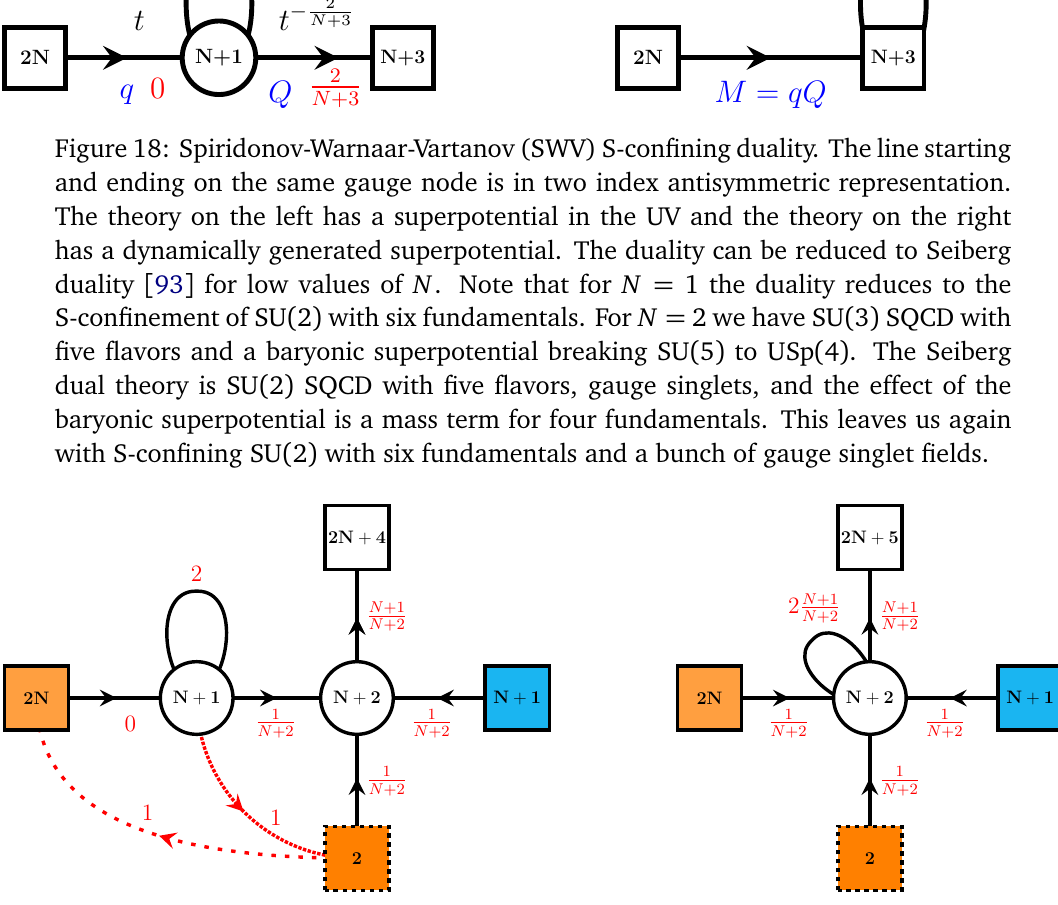
Figure 19: We glue a tube to one of the maximal SU ( N + 1 ) punctures. The dotted line represents the moment map field coming from the tube flipping the baryonic moment map of the trinion. We then use the SWV duality to reduce the dynamics of the SU ( N + 1 ) gauge node to a WZ model and obtain the theory on the right. + 2 Tr RSU ( N + 1 ) 2 = N